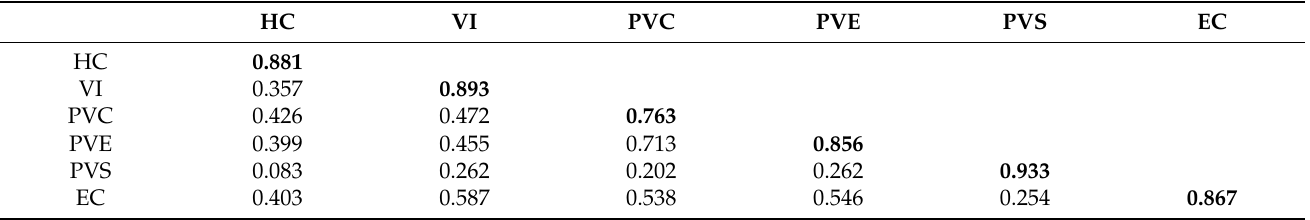
Table 4. The discriminant validity results of the research model.